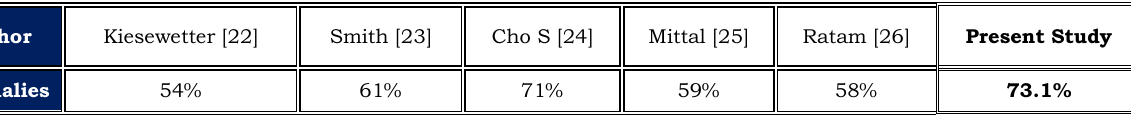
Table 5: Reported incidence of additional anomalies in ARM.